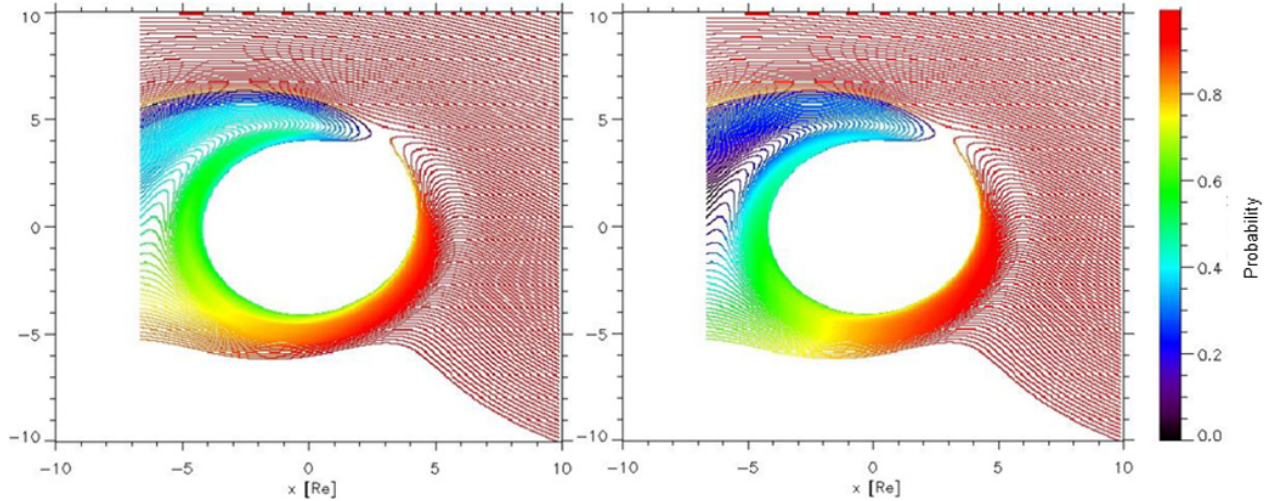
Fig. 11. Probability of remaining injected protons, along their trajectories, with the Hodges and the MSIS-86 exospheric models, (respec- tively, on left and right